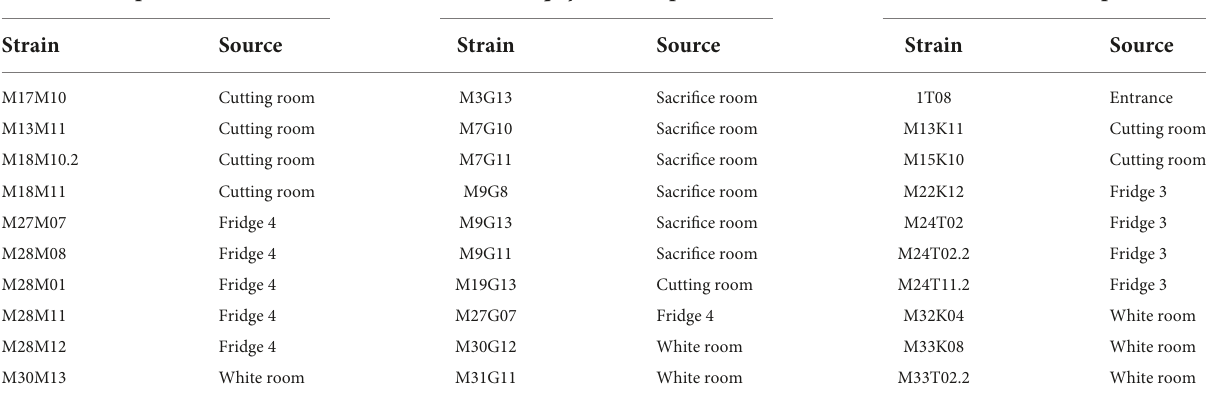
TABLE 1 Bacterial strains used in this study. Enterococcus